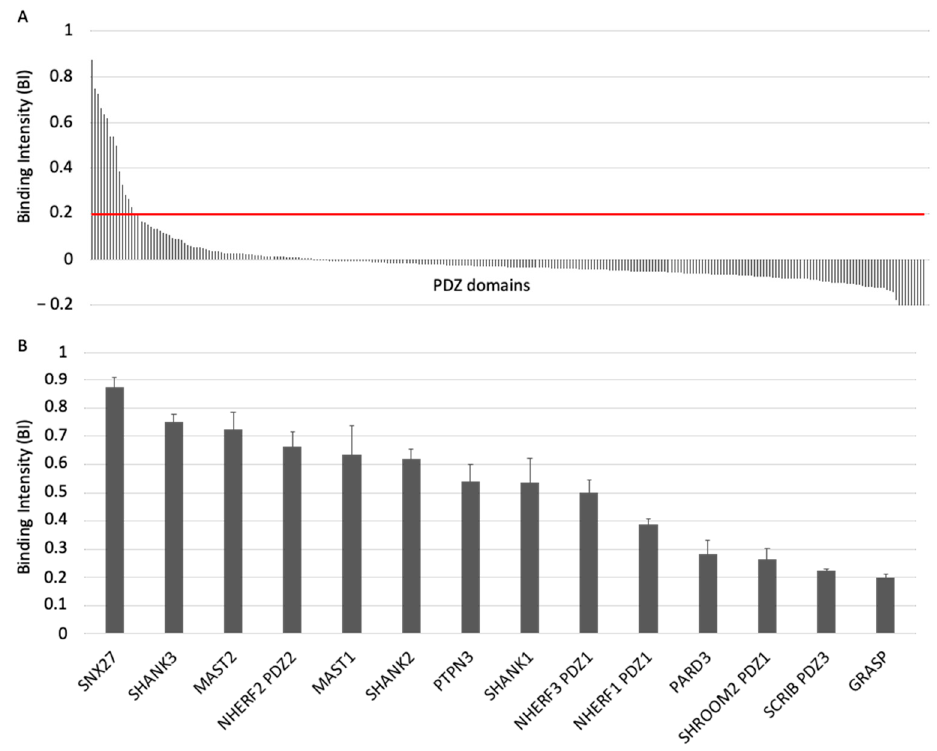
Figure 2. PDZome-binding profile of ACE2 protein PBM by holdup assay. ( A ) PDZ domains are ranked by decreased BI values. A red line indicates the threshold of significant BI at 0.2. ( B ) Zoomed- in view shows the 14 PDZ binders of ACE2 PBM peptide, which displayed BI values higher than 0.2. The data are representative of two independent experiments and error bars correspond to the standard deviation.